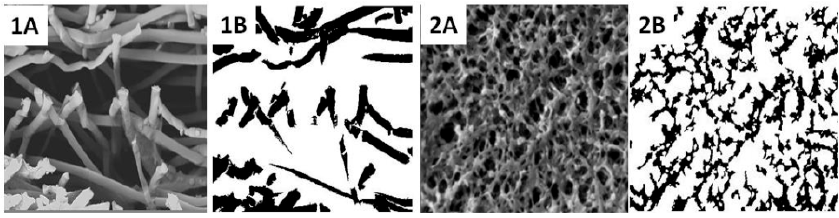
Figure 9. Typical original and black and white cross-section-view SEM images for ( 1A , B ) sample 1 compared to the ( 2A , B ) PVDF membrane.